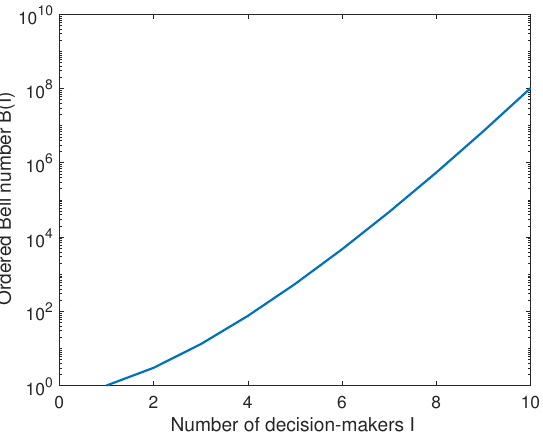
Figure 4. Number of possible hierarchical structures for given set of decision-makers described by the ordered Bell number B ( I )